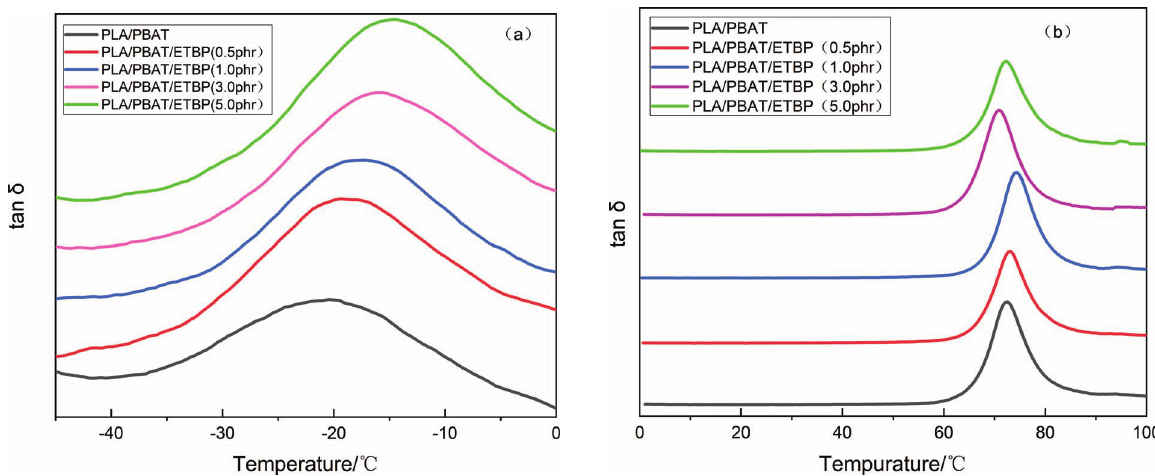
Figure 2: DMA curves of the PLA/PBAT blends with different content of ETBP: (a) tanδ-temperature curve of PBAT; (b) tanδ-temperature curve of PLA.